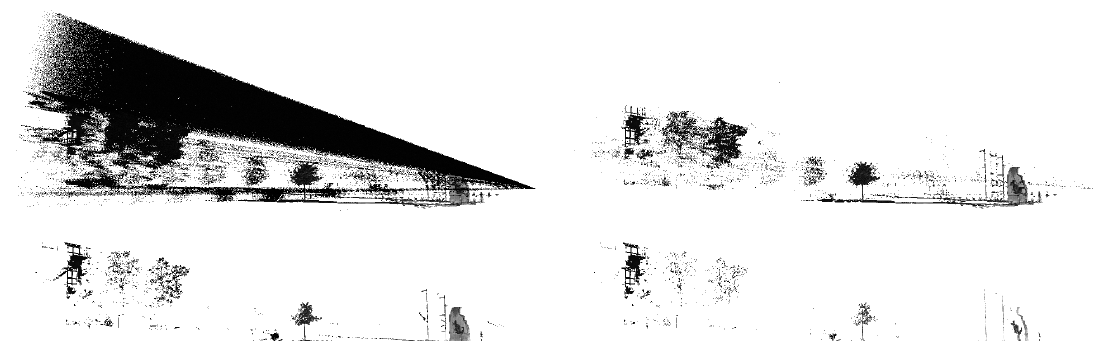
Figure 4. Raw point cloud data (top left), point cloud data filtered via intensity information (top right), point cloud data filtered via the measure of range reliability (bottom left) and point cloud data filtered via the measure of planarity (bottom right). spondences X i,k ↔ x ∗ and thus to relate the task of point j,k